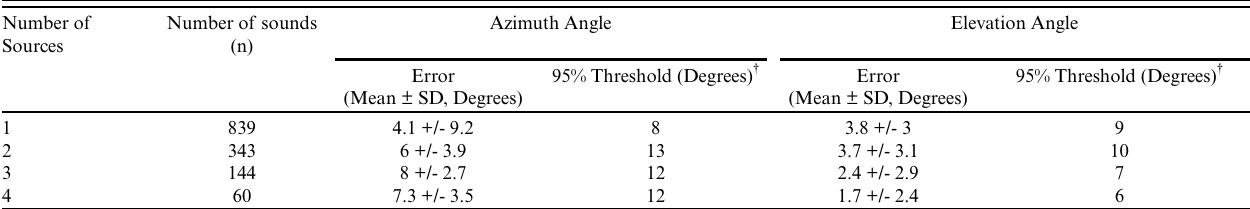
Table 2 . Summary of accuracy of direction-of-arrival (DOA) estimation when different numbers of distinct sources contributed to an analyzed sound, from one source (no overlap) to four sources (maximal overlap).